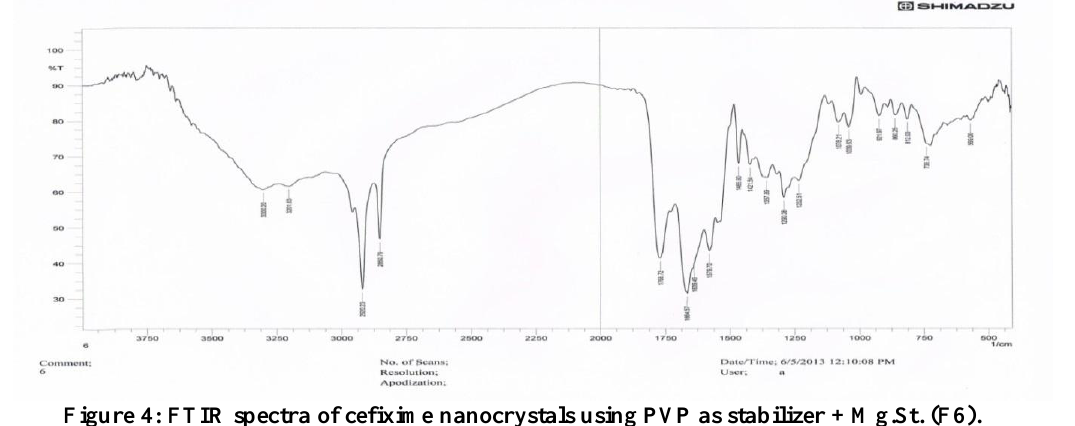
Figure 3: FTIR spectra of PVP.